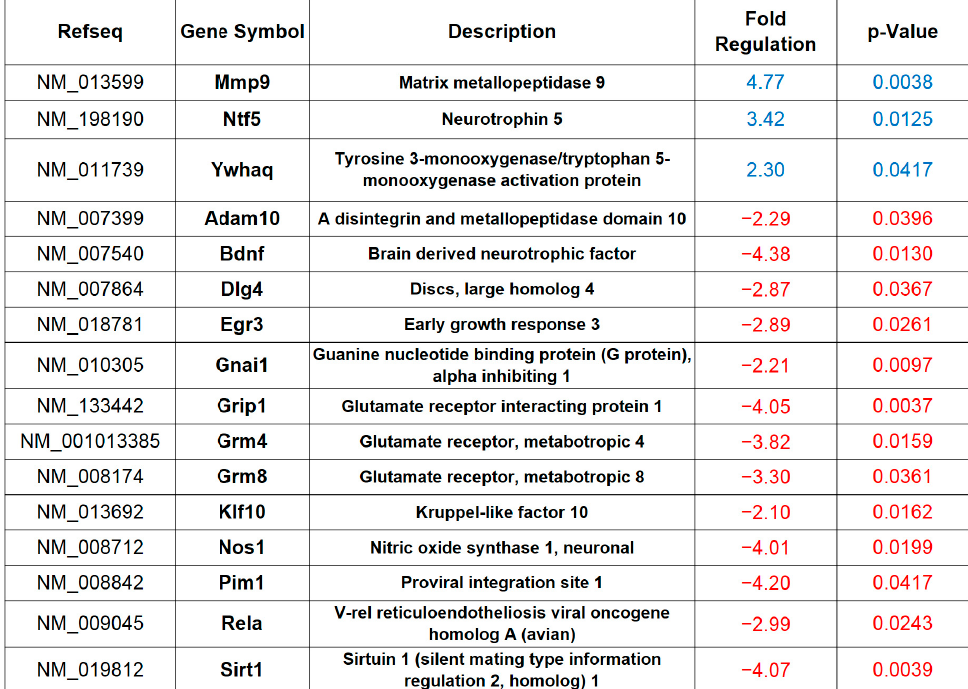
Figure 1. High fat diet (HFD) alters the expression of synaptic plasticity-related genes. Up-down fold expression changes of synaptic plasticity-related genes significantly altered in the hippocampus of mice fed with HFD for six weeks ( n = 4 mice per experimental group). Real-time (RT)-PCR was performed in triplicate. The table shows genes with fold change ≥ 2 and p value < 0.05. The full list of genes and fold expression changes is shown in Supplementary Table